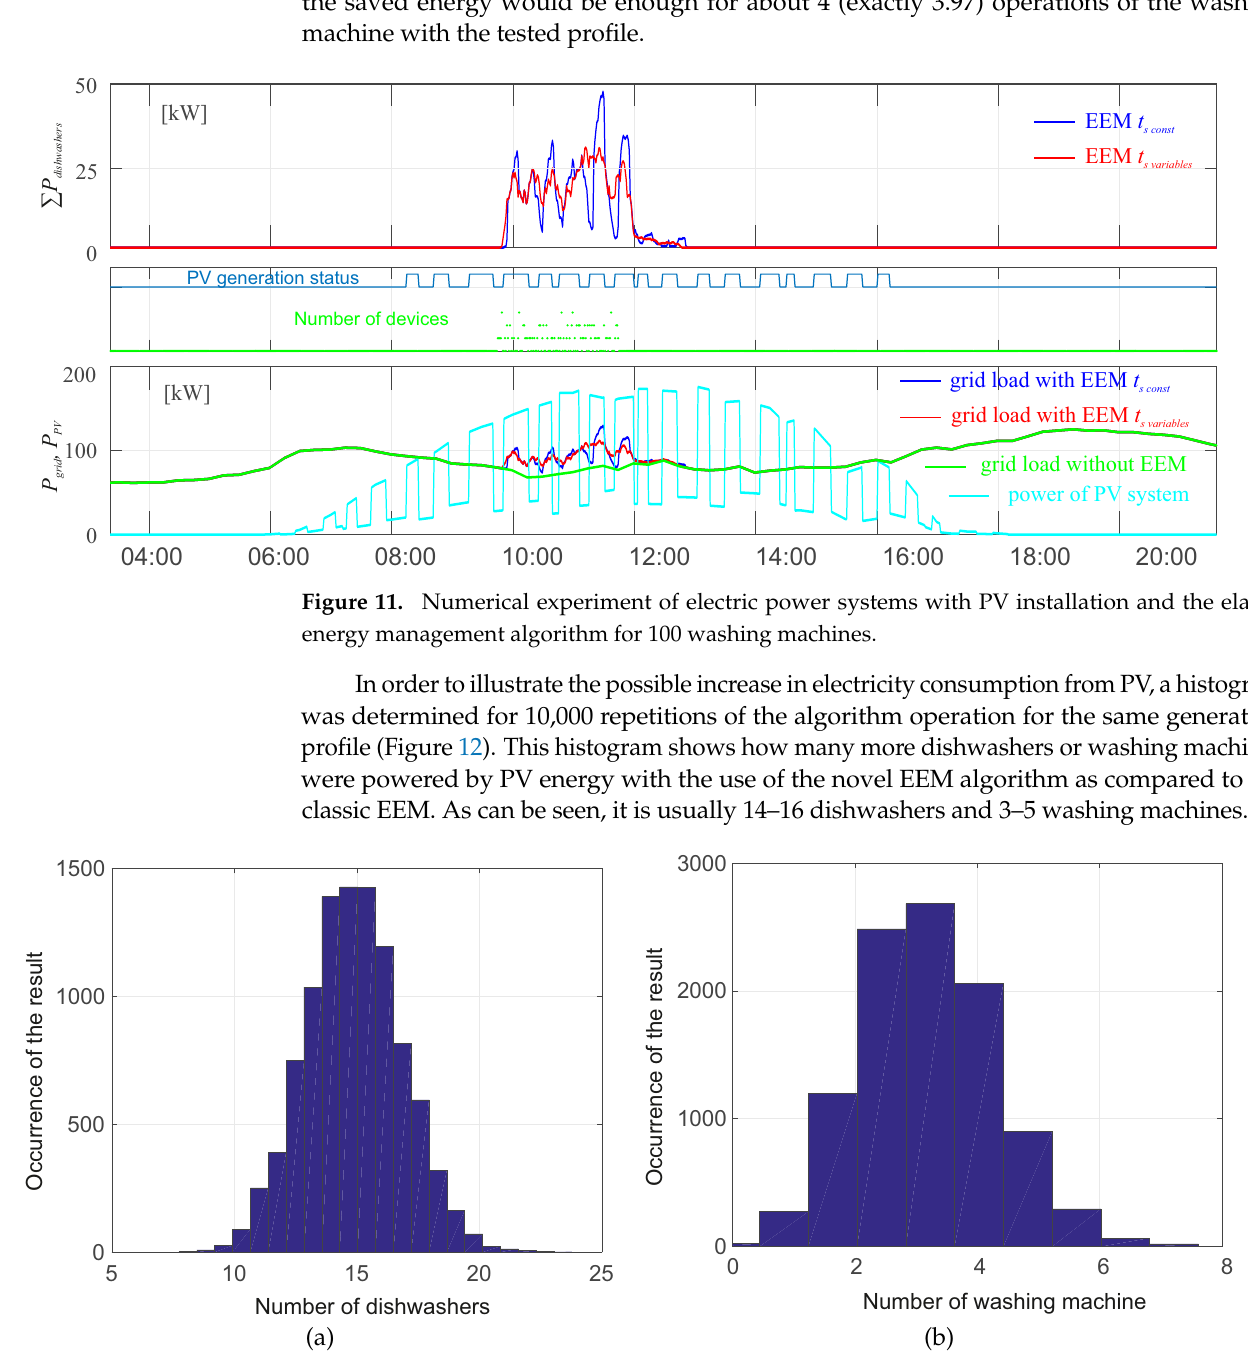
Figure 12. Histogram showing the comparison of EEM ts _ const with EEM ts _ variables at 10,000 repeti- tions of the algorithm for: ( a ) dishwasher, ( b ) washing